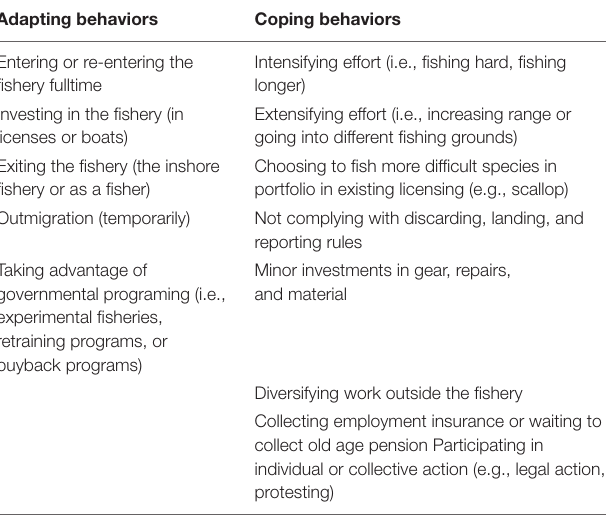
TABLE 2 | Adapting and coping behaviors recorded in the results. Adapting behaviors Coping